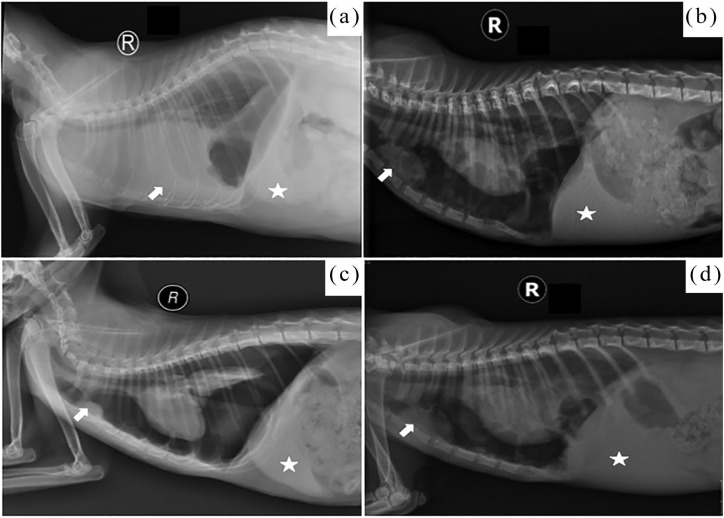
Thoracic radiographs of four cats showing different types of pathologies. Enlargement of the retrosternal lymph node (white arrow) was seen in (b–d) and hepatomegaly (white star) was noted in all four cats. (a) Pleural effusion is indicated by an arrow and alveolar–interstitial pattern of the lungs with air pocket/pneumatocoele below the level of accessory lung lobe. (b) Pneumothorax, cavitary lesion in mid thorax cranial to the diaphragm. (c) Pneumothorax with atelectasis of the the right caudal and accessory lung lobes. (d) Pneumothorax with pneumatocoele just caudal to the apex of the heart and cranial to the diaphragm